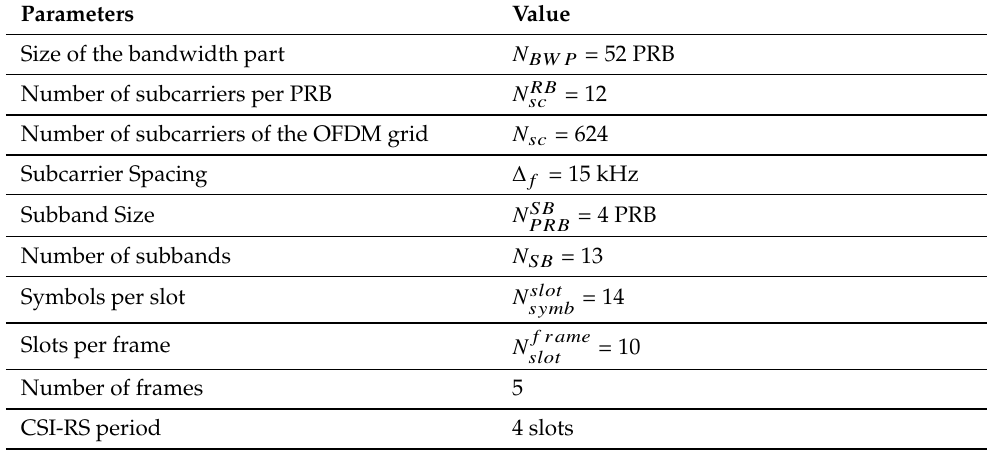
Table 2. Simulation